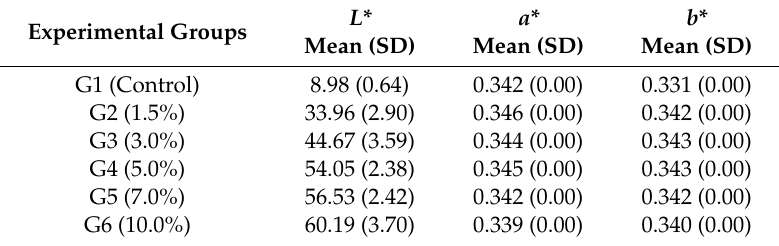
Table 3. Mean and Standard Deviations (SD) of baseline colour measurements after 24 h’s immersion in distilled